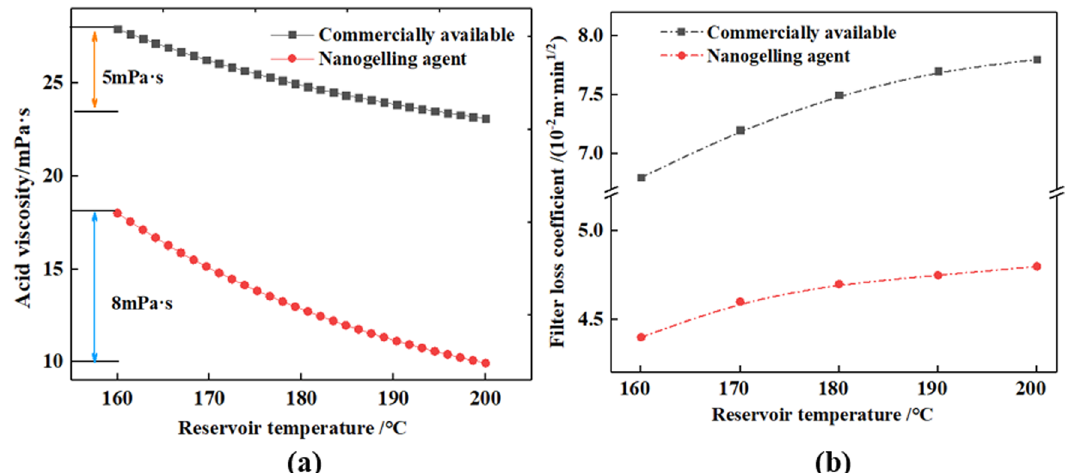
Figure 8: In fl uence of reservoir temperature on viscosity and friction - reducing rate of di ff erent acid solutions: ( a ) e ff ect of reservoir